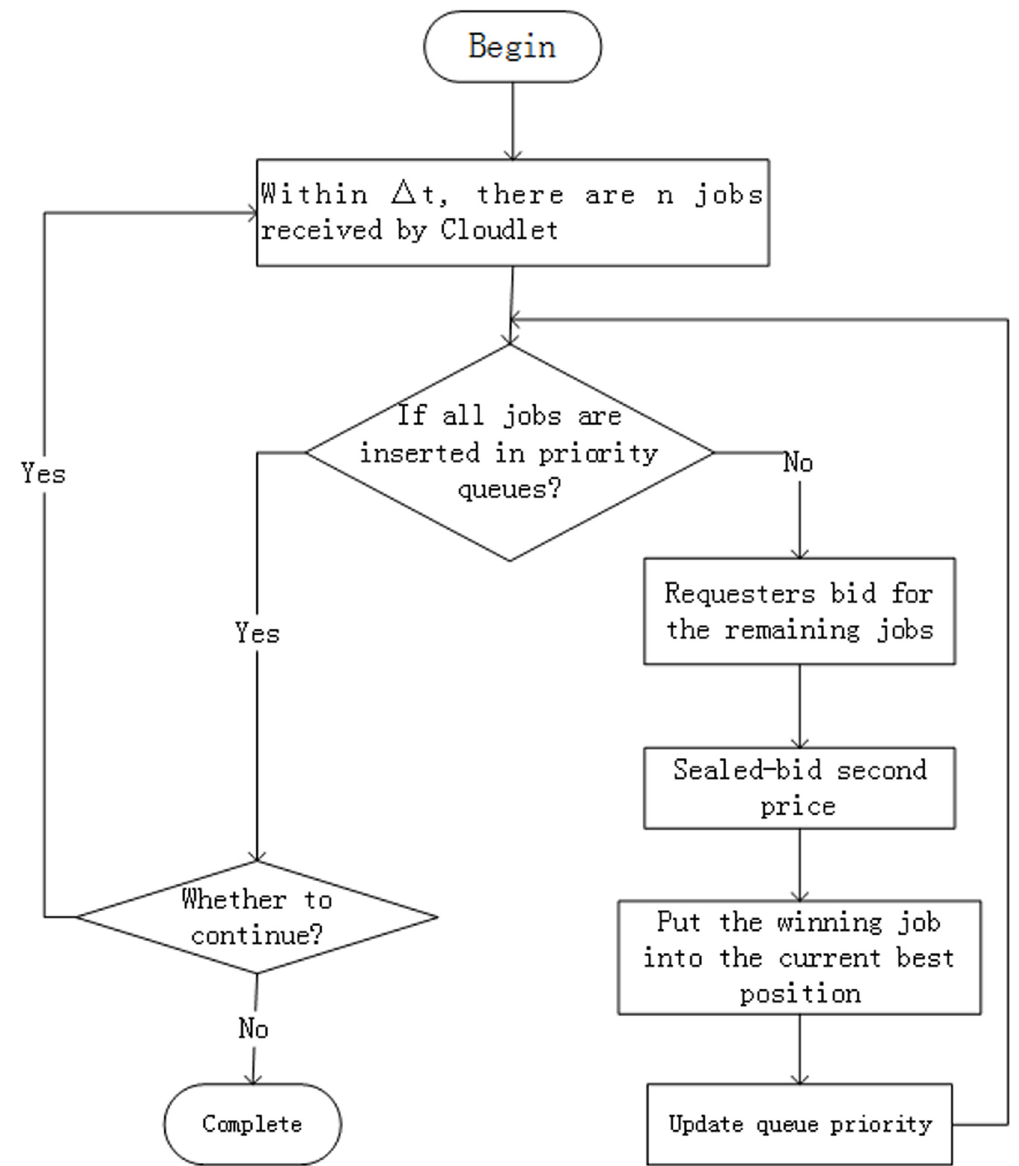
Fig 4. A flowchart of priority